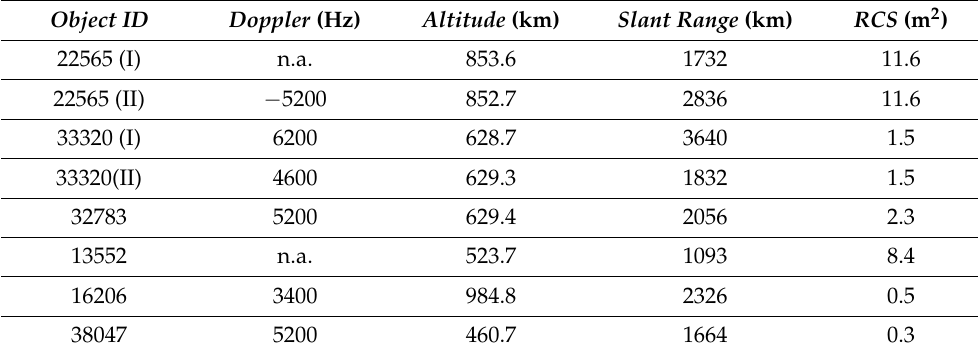
Table 2. Summary of the debris measurements by Bistatic Radar for LEO Tracking (BIRALET) in